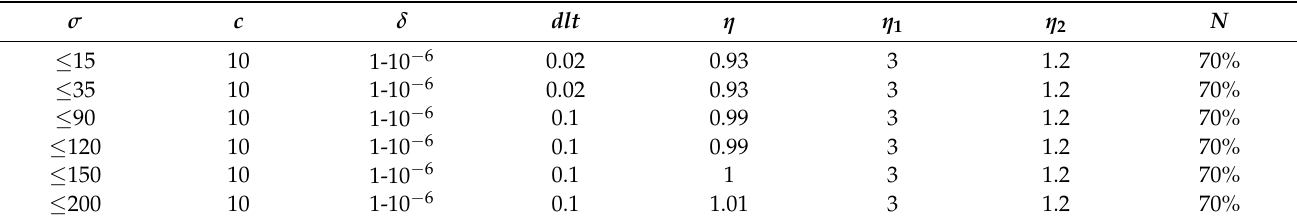
Table 1. Initial parameters of our